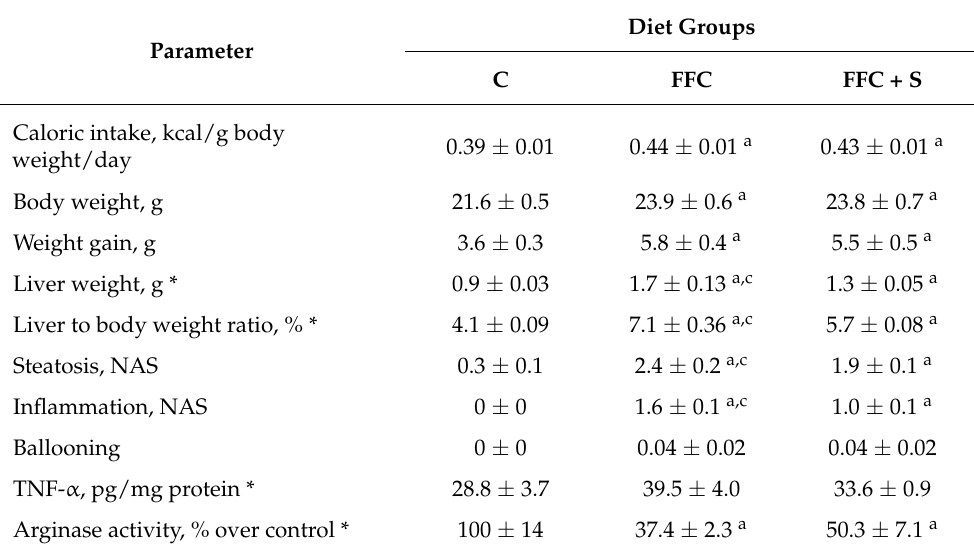
Table 1. Effect of fortifying a fat-, fructose-, and cholesterol-rich diet with 4E% soybean oil on food intake, body weight, and parameters of liver damage in